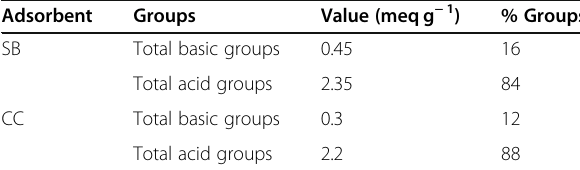
Table 4 Total acid and basic groups of SB and CC